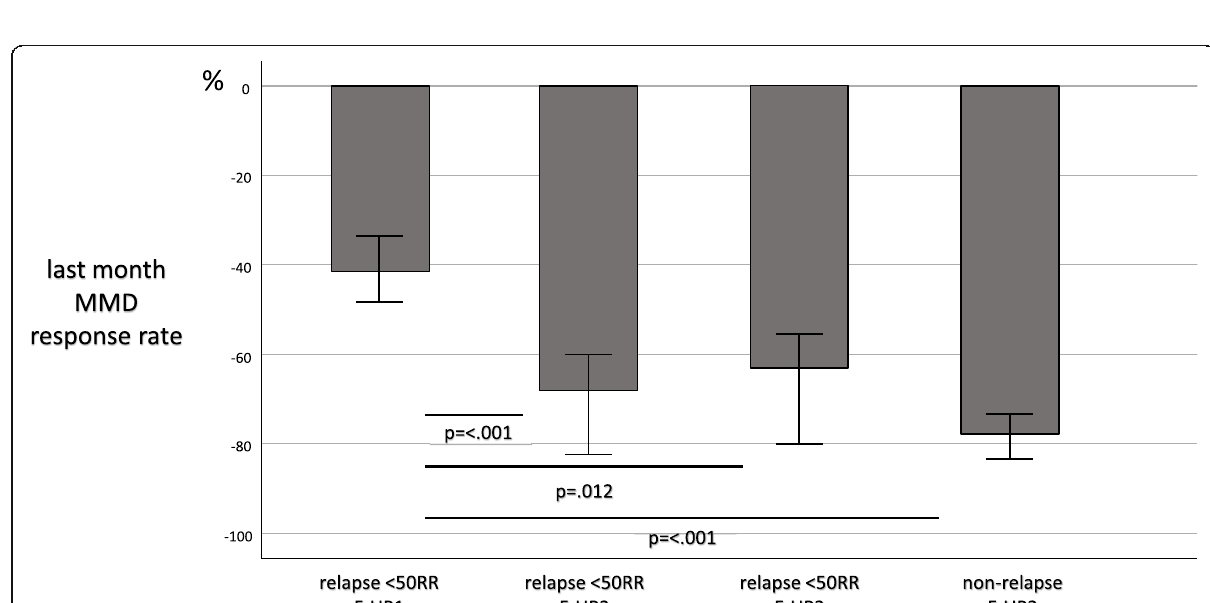
Fig. 3 The median value (95% CI bars) of MMDs percentual reduction in the last month of therapy in patients relapsing to < 50% response rate at F-UP1, F-UP2, F-UP3, and patients still responding at F-UP3 (Mann-Whitney U